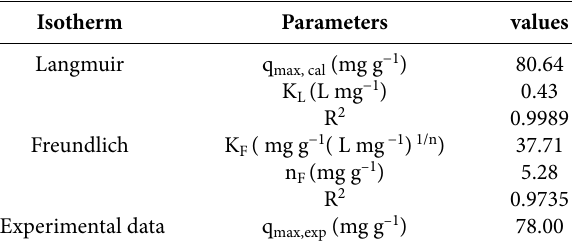
Table 2. Isotherm parameters for MB adsorption by nanozeolite L